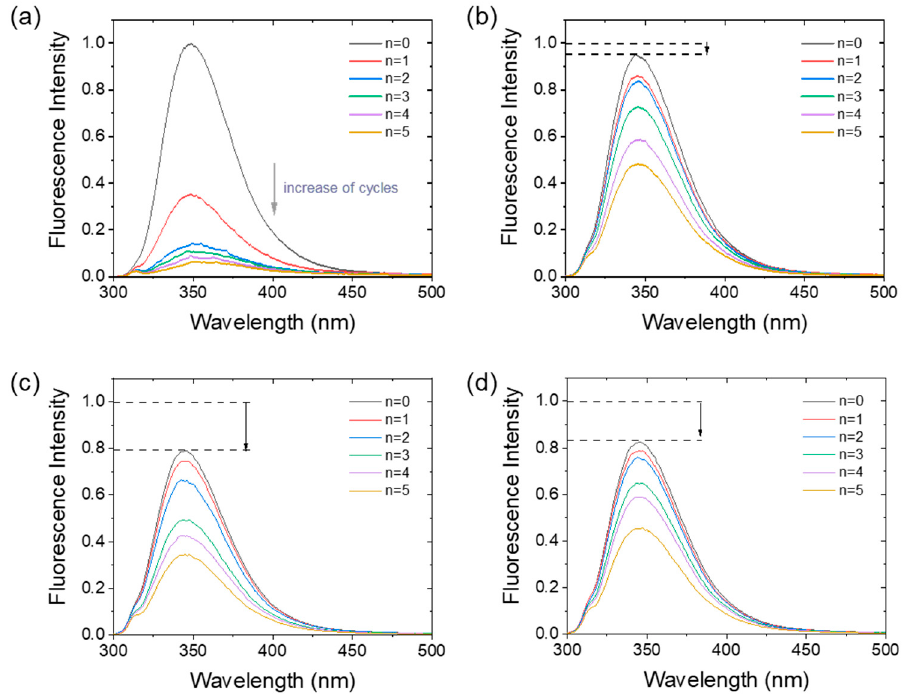
Figure 3. Intrinsic fluorescence of α -amylase ( a ) and α -amylase/ λ -carrageenan mixtures (( b ): 100:1, ( c ): 10:1, and ( d ): 1:1) after PEF treatment with 0–5